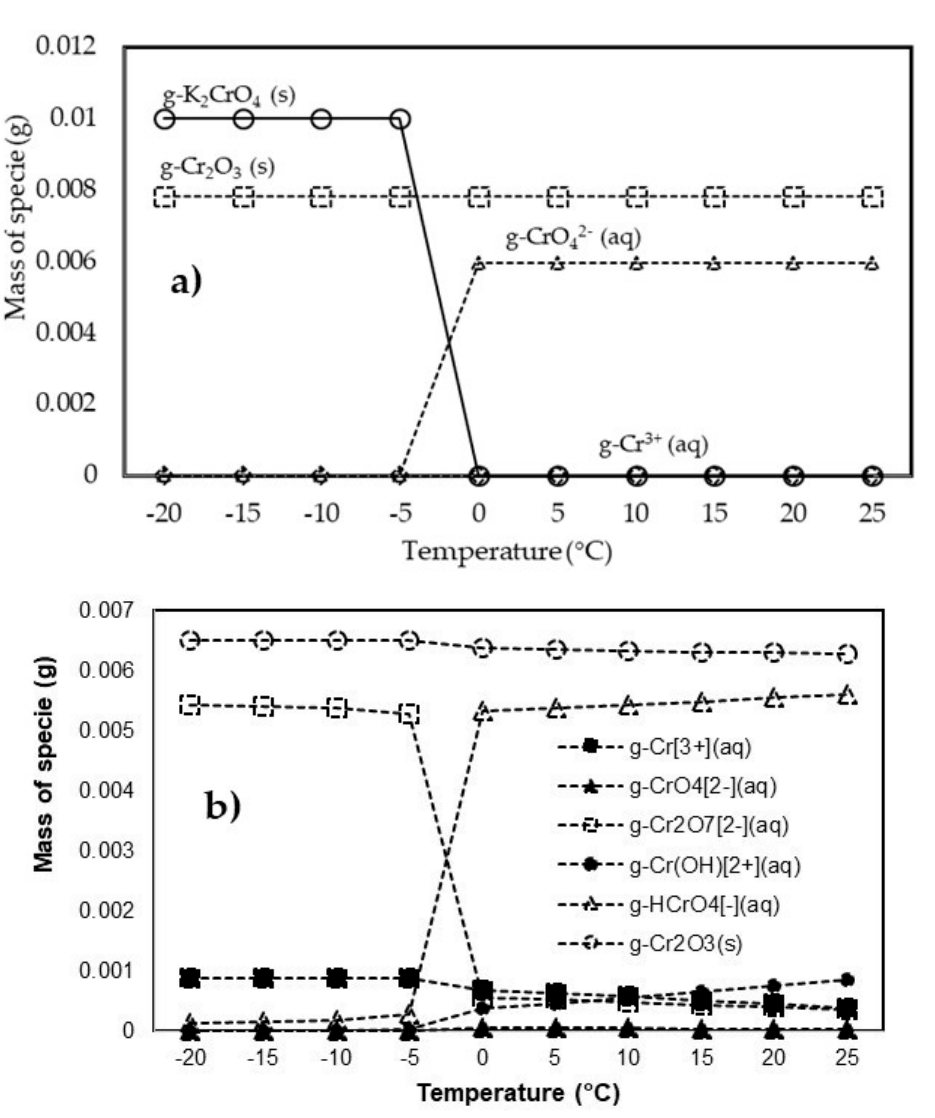
Figure 5. Leaching mechanism of predicted chromate (CrO 2 ) as function of temperature: ( a ) with addictive and ( b ) without addictive.